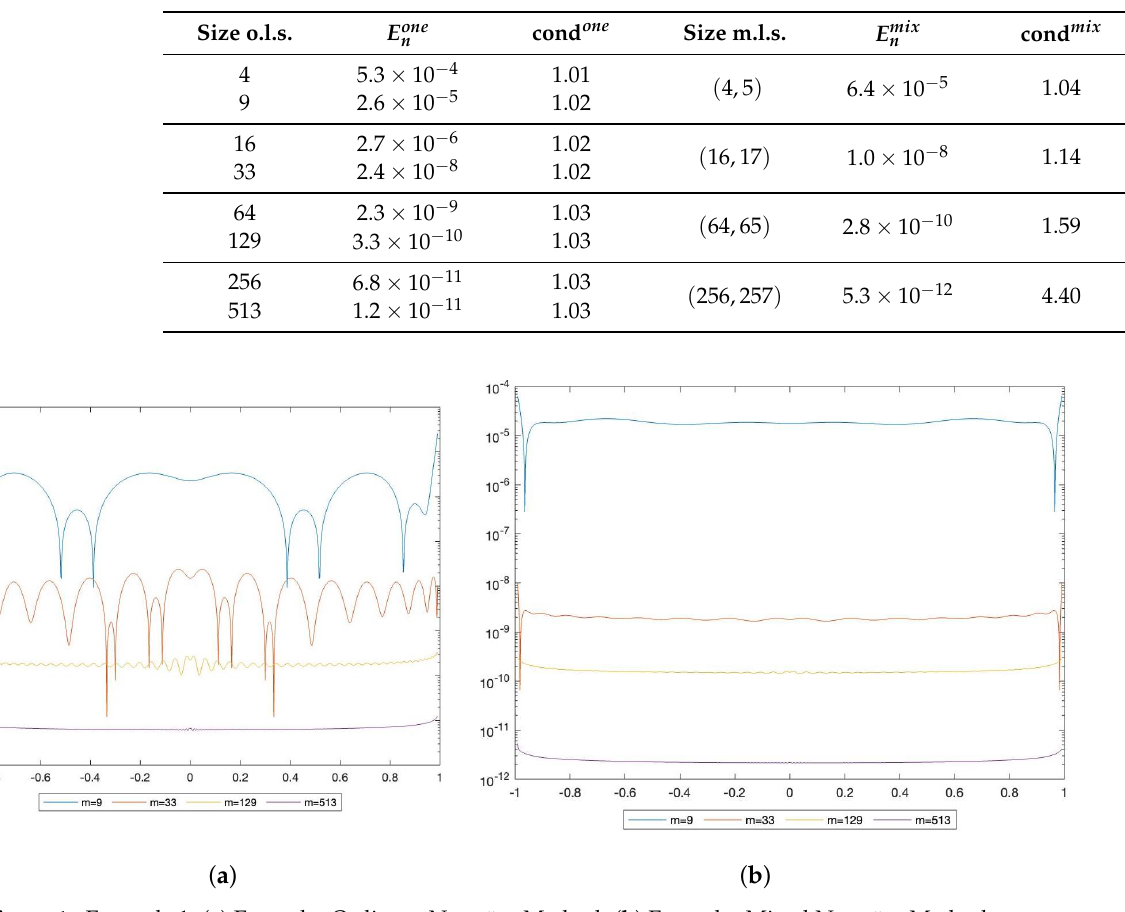
Figure 1. Example 1. ( a ) Errors by Ordinary Nyström Method. ( b ) Errors by Mixed Nyström